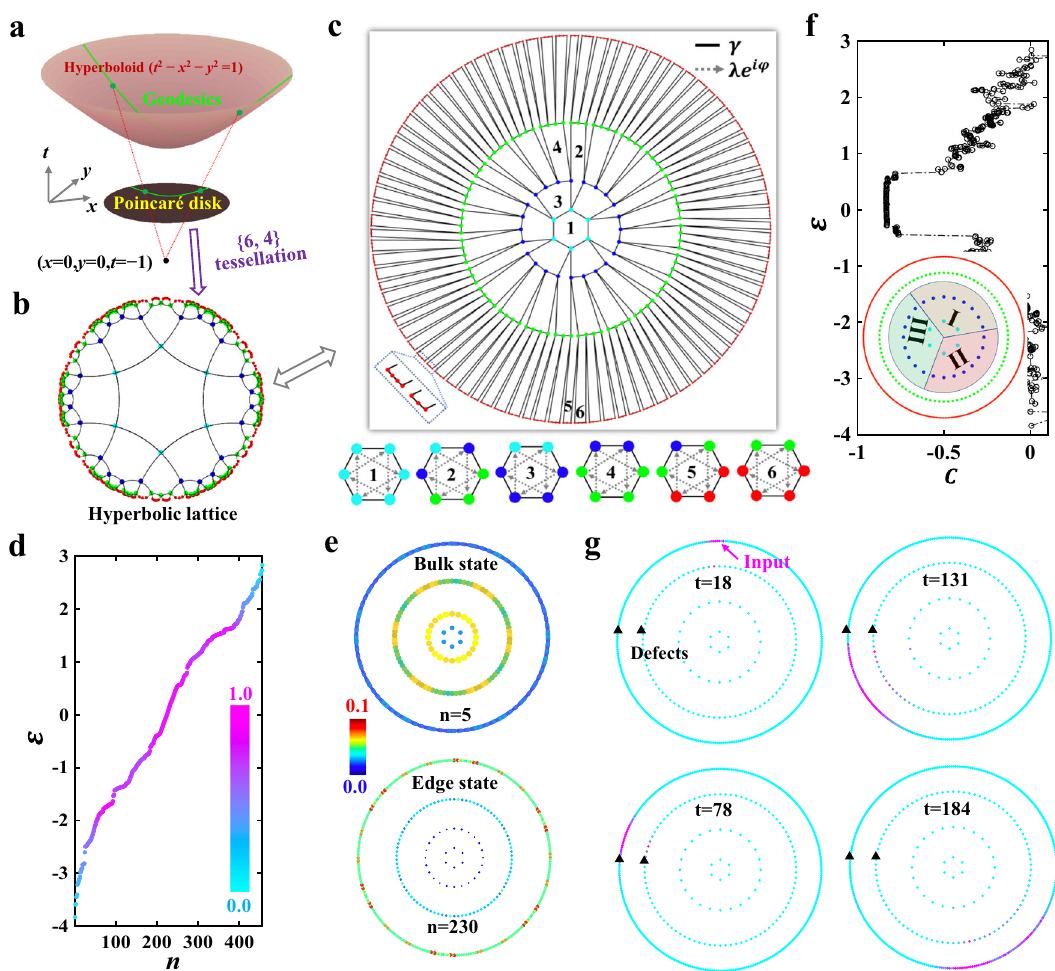
Fig. 1 Hyperbolic Haldane model and boundary-dominated fi rst-order topological edge states. a The left chart illustrates the stereographic projection scheme of a hyperbolic plane ( t 2 − x 2 − y 2 = 1) onto the Poincaré disk at t = 0. Green lines represent the geodesics on the hyperboloid, which are projected to circular arcs perpendicular to boundaries of the Poincaré disk. b The hyperbolic lattice {6, 4} embedded into the Poincaré disk. c The fi nite hyperbolic lattice {6, 4} in the form of successive quasi-concentric rings with L = 4 layers. The left-bottom inset displays the enlarged view of the outermost layer. Right insets plot coupling patterns in hexagons composed of lattice sites from different layers. d The calculated eigen-spectrum of the system with L = 4. The colormap corresponds to the quantity V ð ε Þ for the localization degree at the boundary. e Pro fi les of bulk and edge states with eigen- energies of − 3.445 and 0.1406. f The calculated real-space Chern number of each eigenmode. The inset plots three different regions I, II and III used in the calculation. g Four charts present the spatial distributions of j φ t ð Þj at different times with t = 18, 78, 131, and 184, i